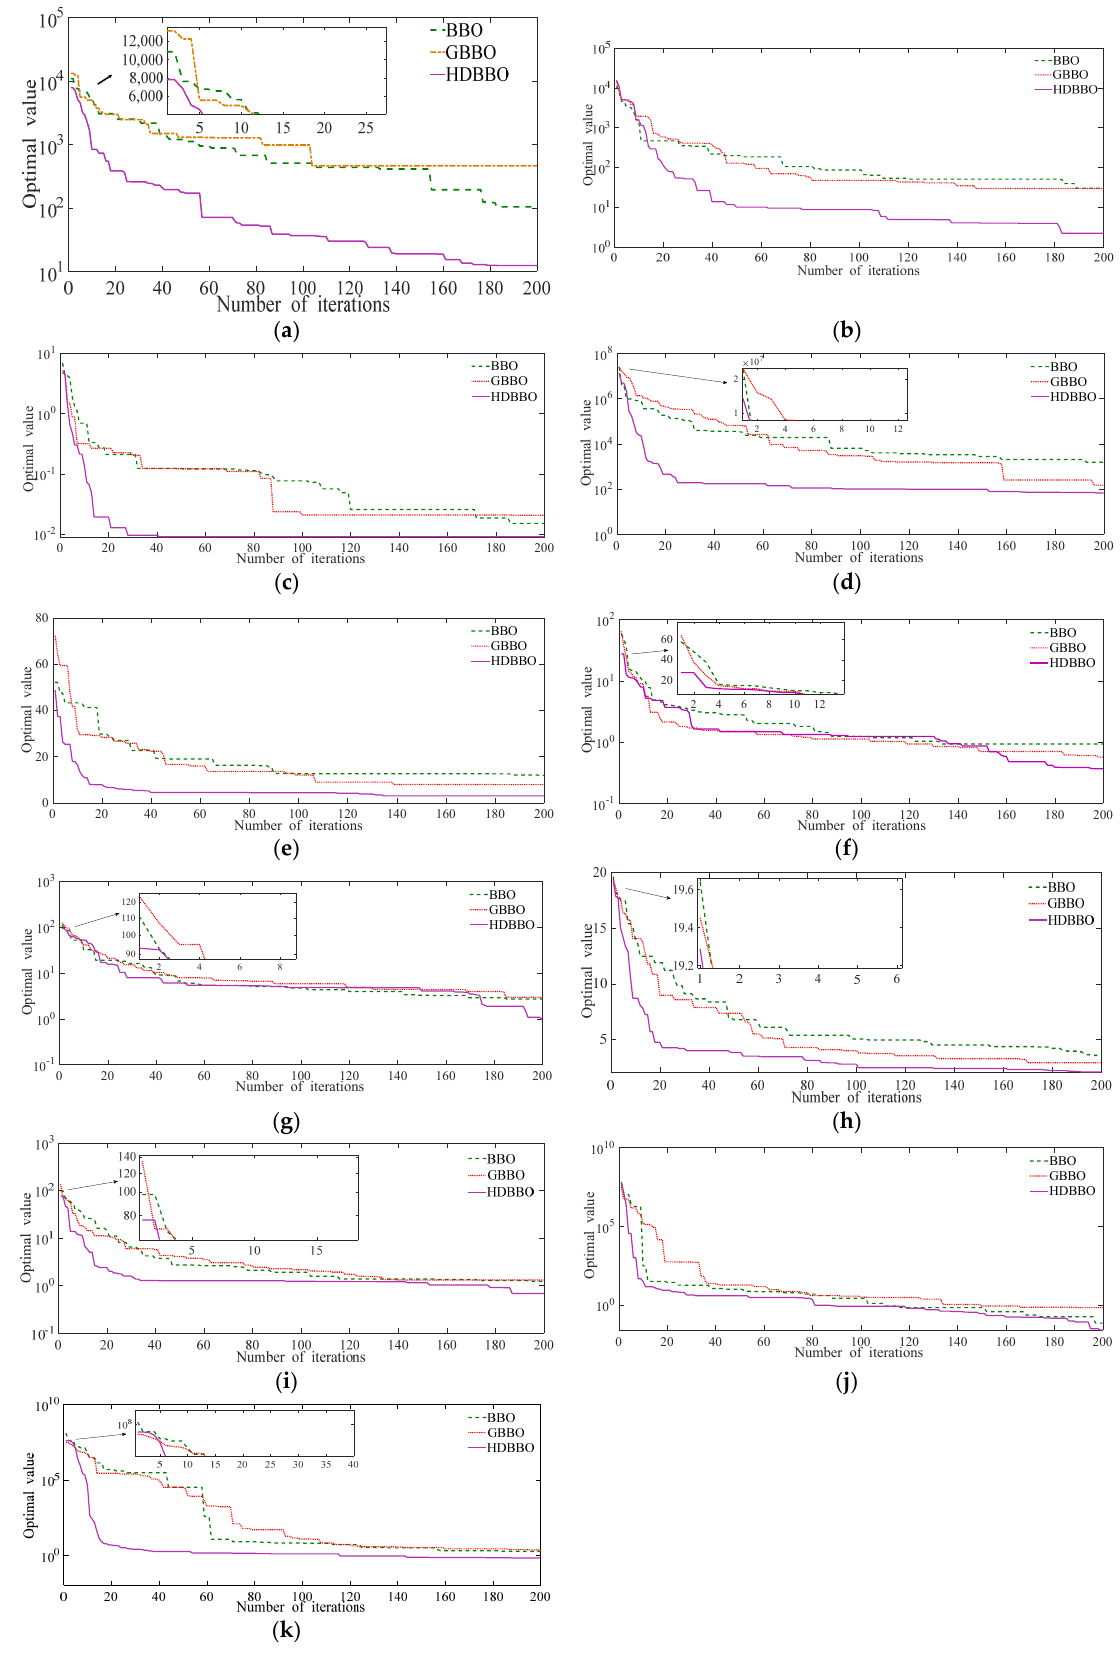
Figure 4. Comparison of the three algorithms on 11 benchmark functions ( a – k ) on the convergence of f 1 − f 11 .( a ) convergence of the three algorithms on benchmark function f 1 ; ( b ) convergence of the three algorithms on benchmark function f ; ( c ) convergence of the three algorithms on 2 benchmark function f ; ( d ) convergence of the three algorithms on benchmark function 3 convergence of the three algorithms on benchmark function f ; ( f ) convergence of the three algo- 5 rithms on benchmark function f ; ( g ) convergence of the three algorithms on benchmark function 6 7 f ; ( h ) convergence of the three algorithms on benchmark function 8 f ; ( i ) convergence of the three algorithms on benchmark function 9 f ; ( j ) convergence of the three algorithms on benchmark func- tion 10 f ; ( k ) convergence of the three algorithms on benchmark function